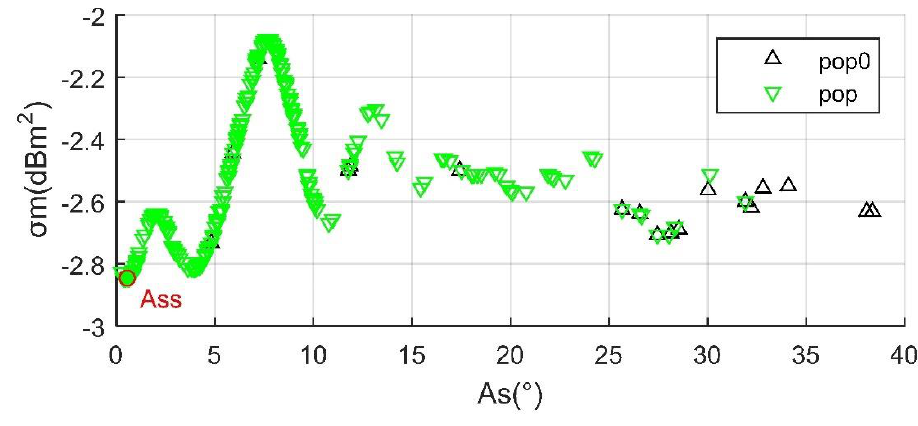
Figure 13. Auto sweep angle for the aircraft, where α n = 60° , α m = 150°, β = − 6°, and F rv = 5 GHz.